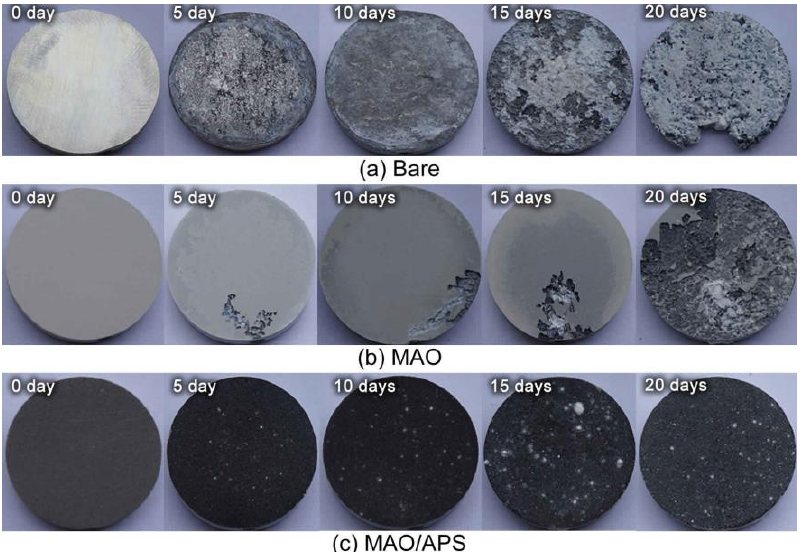
Figure 9. Macro morphology of samples after immersion: ( a ) bare; ( b ) MAO; ( c ) MAO/APS